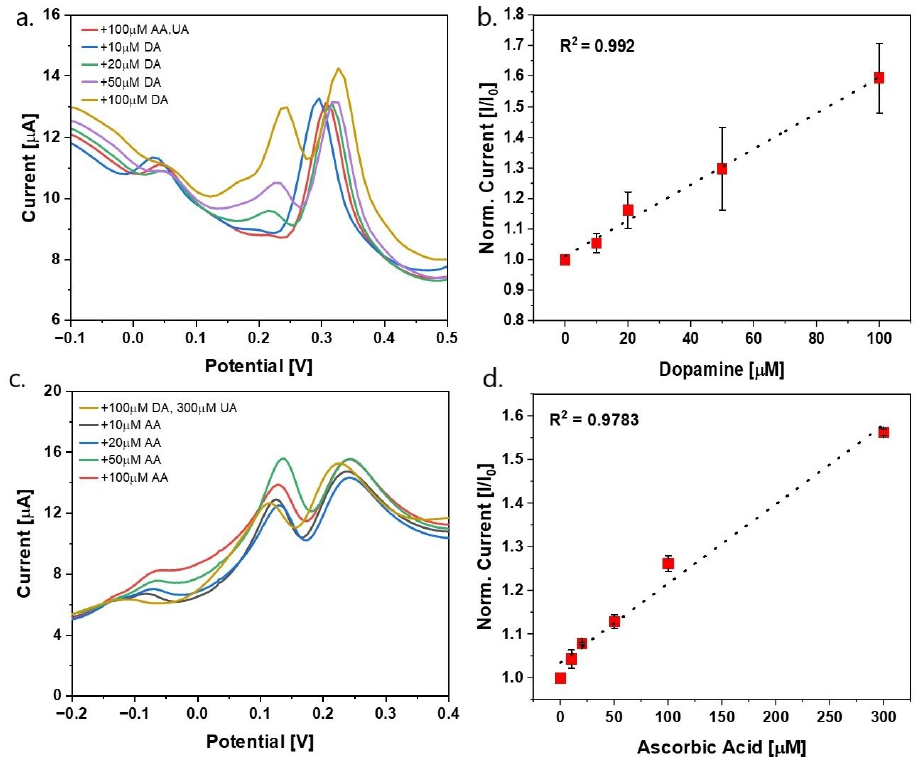
Figure 5. Detection of DA, AA, and UA in the presence of each other. ( a ) DPV response of DA in the presence of AA and UA; ( b ) Calibration plot showing sensor response to dopamine alone in the presence of AA and UA; ( c ) DPV response of AA in the presence of DA and UA; and ( d ) Calibration plot showing sensor response to AA alone in the presence of DA and